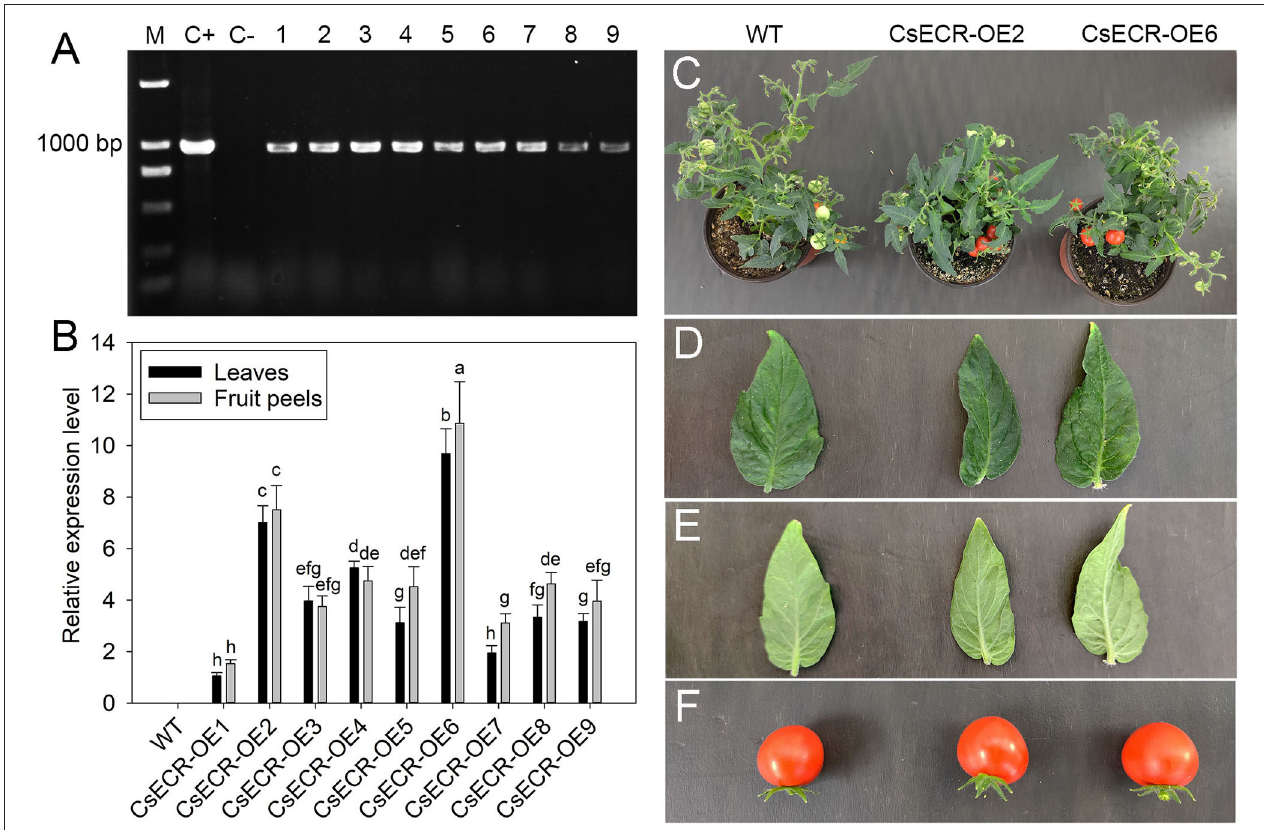
FIGURE 3 | Identification and phenotype analysis of positive transgenic tomato lines. (A) Identification of positive transgenic tomato lines by PCR using CaMV35S sense primer and CsECR antisense primer. M: standard DNA maker; C + : positive control (plasmid contained recombinant expression vector pCAMBIA1301-CsECR); C–: DNA from the wild-type (WT) tomato leaves. Number 1–9: positive transgenic tomato lines. (B) Expression levels of CsECR in leaves and fruit peels of the WT and positive transgenic tomato lines (CsECR-OE1 to CsECR-OE9) were investigated by qRT-PCR. (C) Phenotype of the WT and two positive transgenic tomato lines. (D, E) Phenotype of the adaxial and abaxial sides of leaves, and (F) fruits of the WT and two positive transgenic tomato lines (CsECR-OE2 and CsECR-OE6). Vertical bars represent standard deviations of the means ( n = 3). Different small letters represent significant differences at P < 0.05 according to Duncan’s multiple range